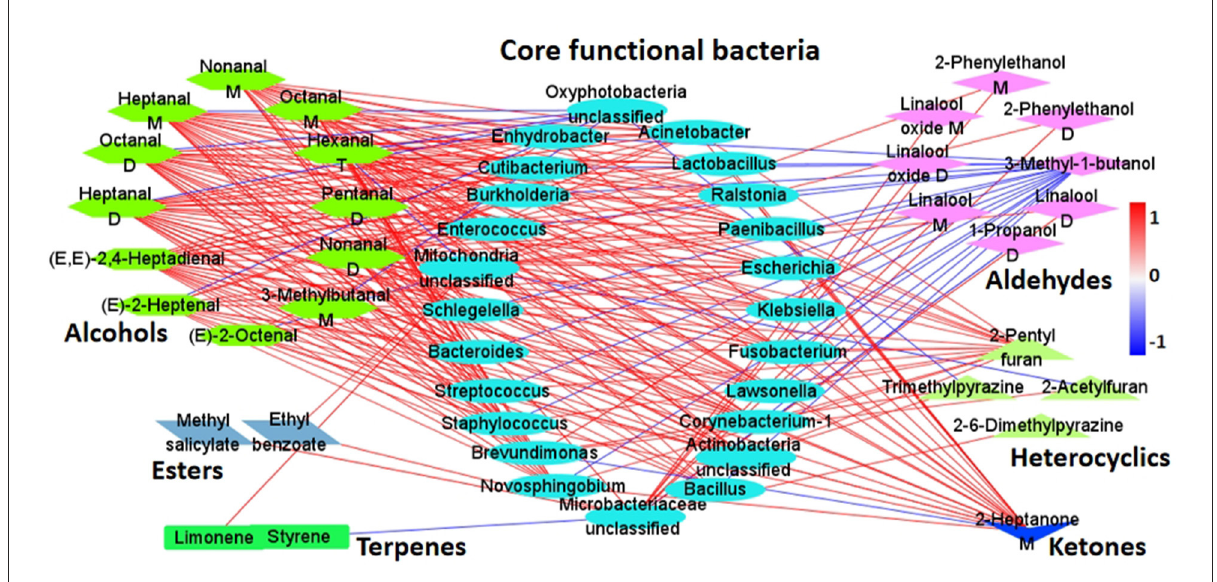
FIGURE8 Correlation between core functional bacteria and VOCs. The red line indicated a significant positive correlation, and the blue line indicated a significant negative correlation, and the darker the color, the greater the correlation ( P < 0.05).